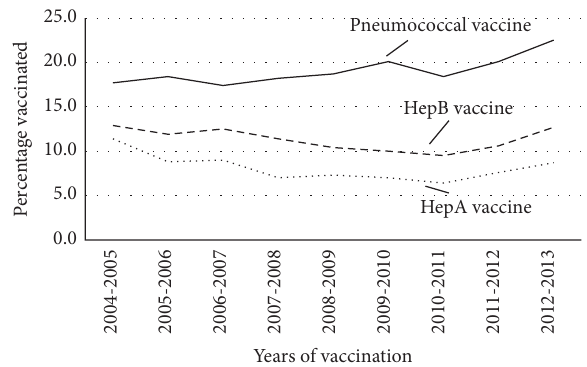
Figure 2: Percentage of total cirrhotics vaccinated between 2004 and 2013. Time represented as years of vaccination (same or following year of cirrhosis